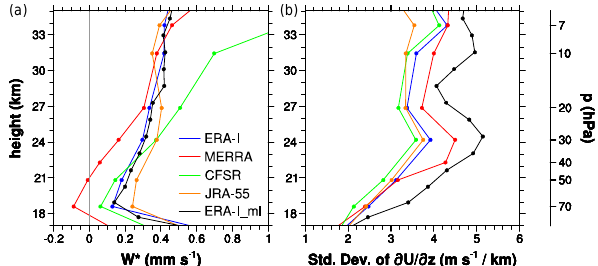
Figure 5. (a) Mean residual vertical velocity and (b) standard devia- tion of the monthly and zonal mean wind shear for the period 1979– 2010 averaged over 5 ◦ N–5 ◦ S, obtained using the p -level data of ERA-I (blue), MERRA (red), CFSR (green), and JRA-55 (orange) as well as the model-level data of ERA-I